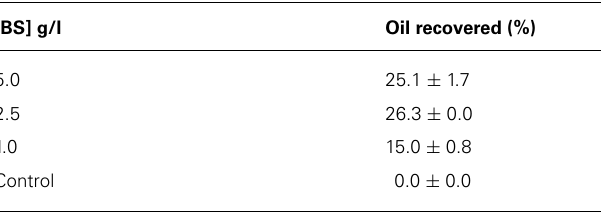
Table 6 | Percentages of oil recovered with the biosurfactant produced by B. subtilis #573 in the medium CSL 10% at different